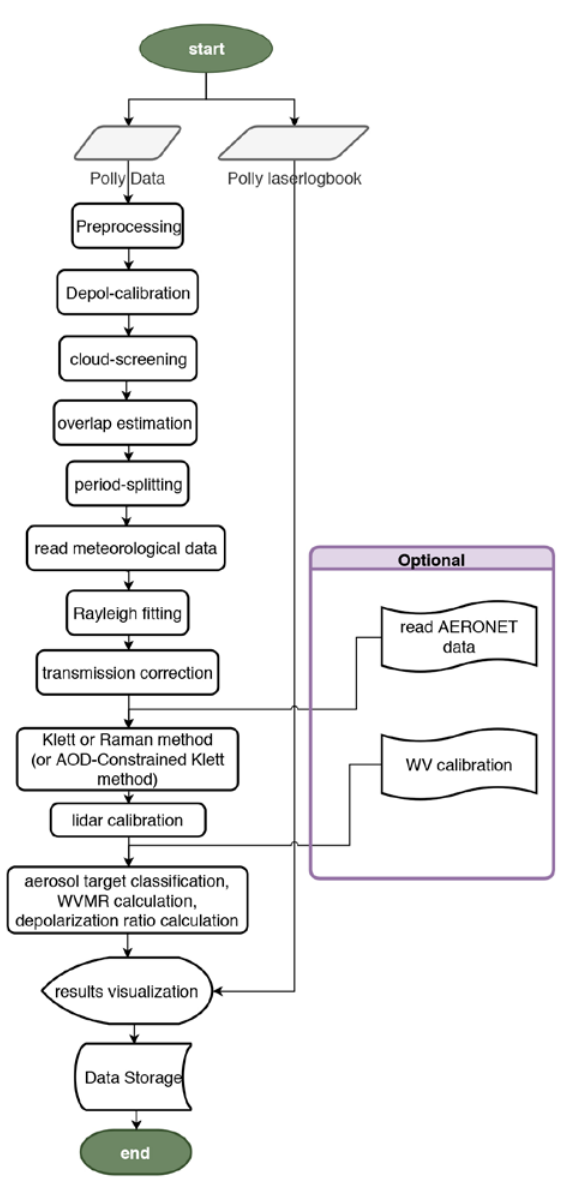
Figure 1. Flowchart of the PollyNET processing chain. (Optional parts mean the modules are dependent on the available AERONET sites nearby).